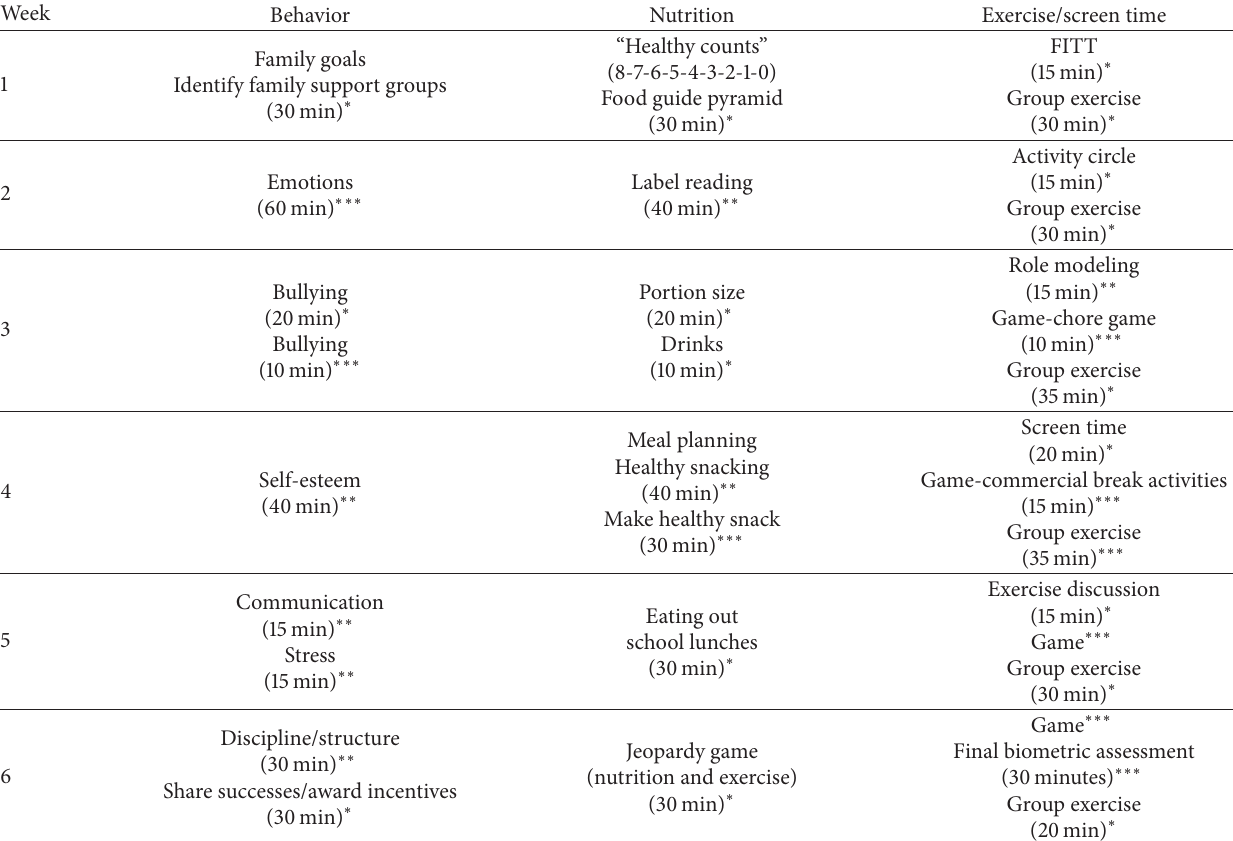
Table 2: The FitKids360 curriculum. ∗ = patients and parent(s), ∗∗ = parents only, and ∗∗∗ = patients only. Each class begins with 10 minutes of group discussion regarding goals. Each class ends with 5 minutes to set and write new goals.